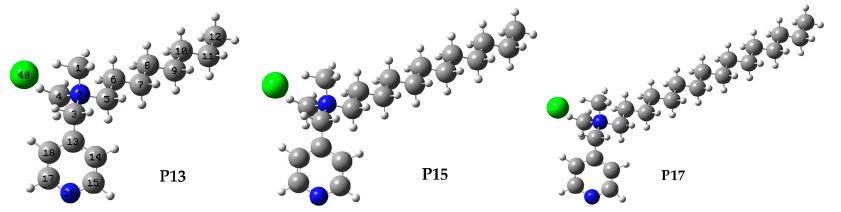
Figure 2. Representative molecular models of compounds P13 , P15 and P17 .